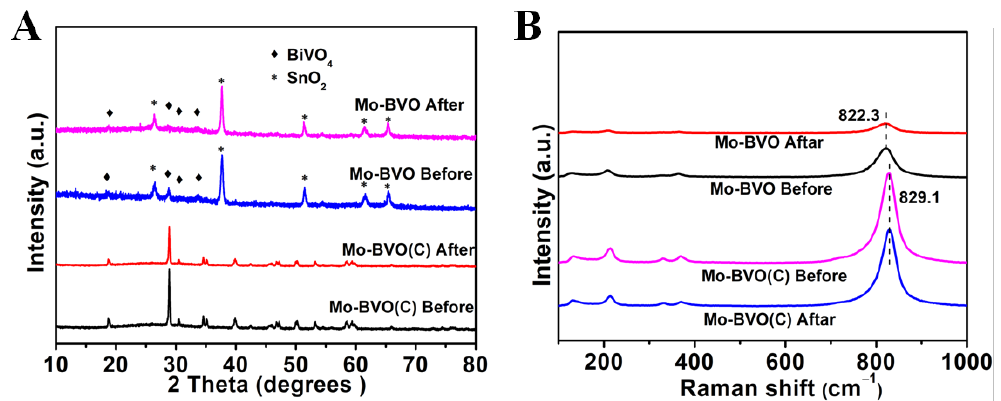
Figure 4. ( A ) XRD data of Mo-BVO and Mo-BVO (C) before and after PEC for 4 h and 10 h in a KPi solution, respectively. ( B ) Raman spectrum of Mo-BVO and Mo-BVO (C) before and after PEC for 4 h and 10 h, respectively.